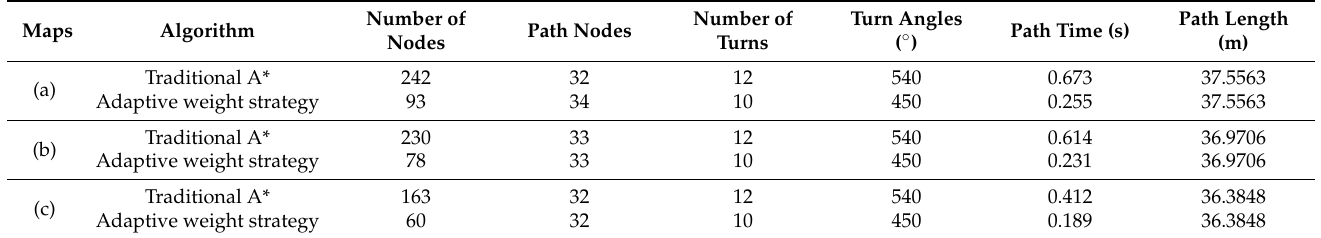
Table 3. Comparison of the planning results of the two algorithms on a map with randomly generated obstacles.